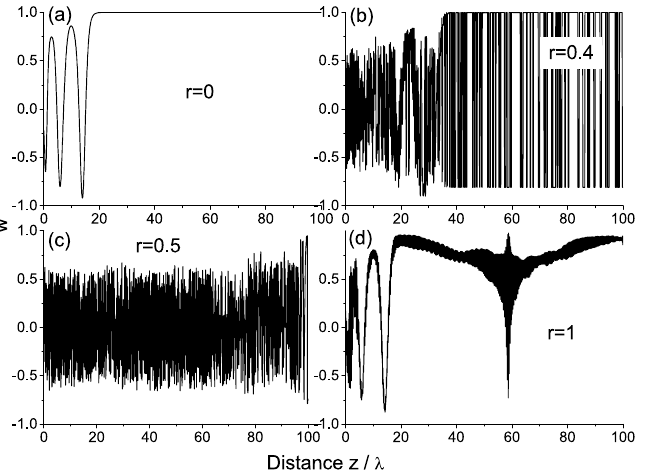
Figure 4. Distributions of population difference along the medium with different disorder strengths r at the time instant t = 20 t p . The medium is excited by the non-adiabatic wave